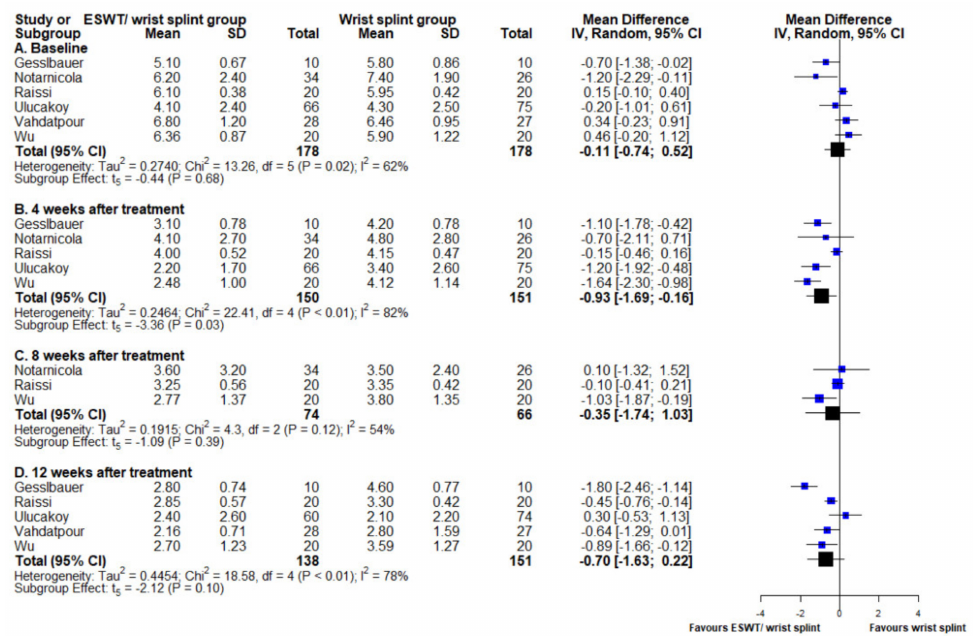
Figure 5. Forest plot of mean difference in VAS between ESWT/night wrist splint and night wrist splint alone groups at (A) baseline, (B) 4 weeks after intervention, (C) 8 weeks after intervention, and (D) 12 weeks after intervention. Mean difference and standard deviation of each enrolled study and the meta-analysis results were presented as blue and black squares at the left column of the figure,